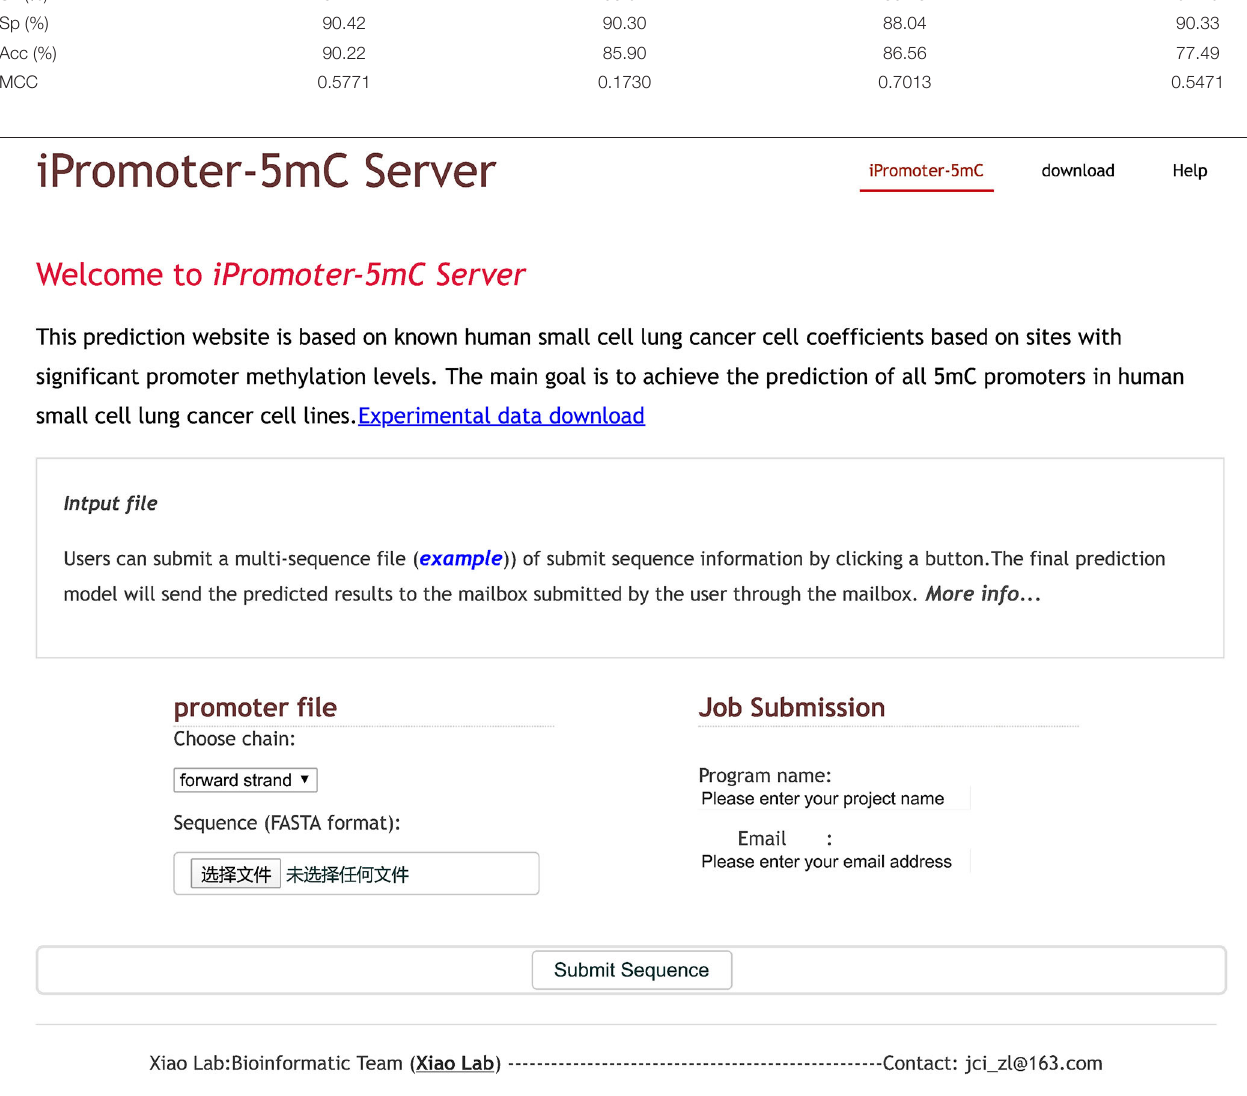
FIGURE 7 | Screen shots of the homepage of the iPromoter-5mC web server.